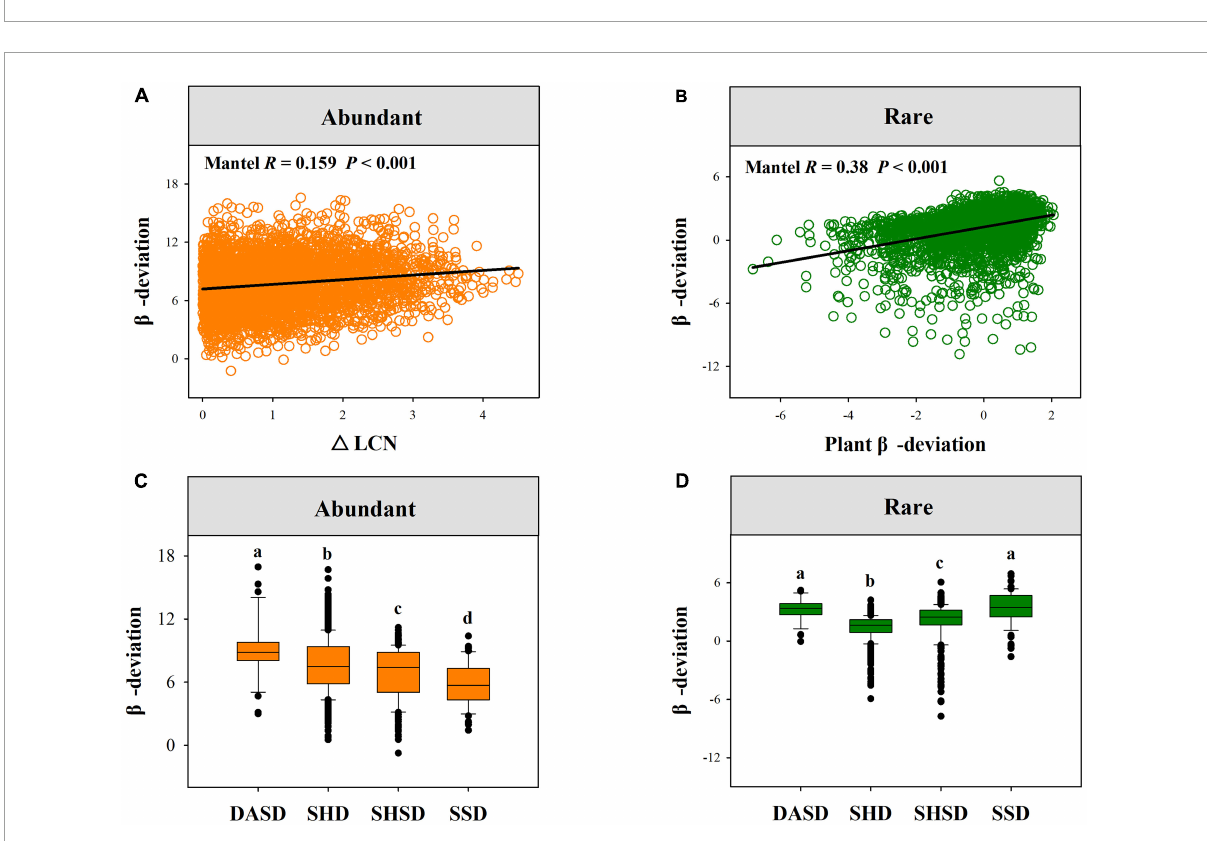
FIGURE5 The relationships between fungal β -deviation and difference in plant attributes. (A) Showed the relationships between abundant fungal β -deviation and difference in LCN. (B) Showed the relationships between rare fungal and plant β -deviation. (C,D) Showed the variation in the β -deviation of abundant and rare fungi across four vegetation types. SSD, shrubby steppe desert; SHSD, semi-shrubby and dwarf semi-shrubby desert; SHD, shrubby desert; DSAD, dwarf semi-arboreous